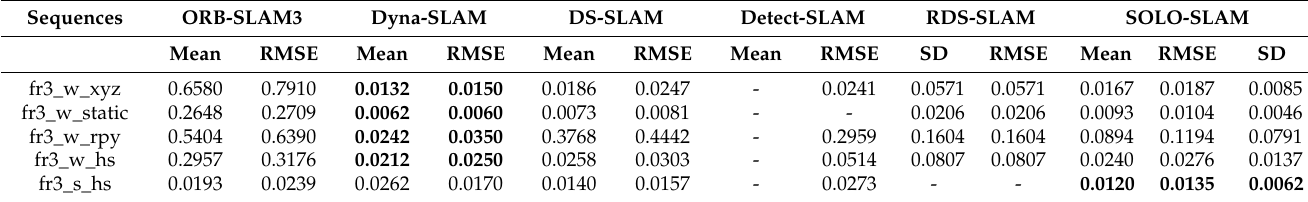
Table 1. Experimental results of absolute trajectory error (ATE [m]).